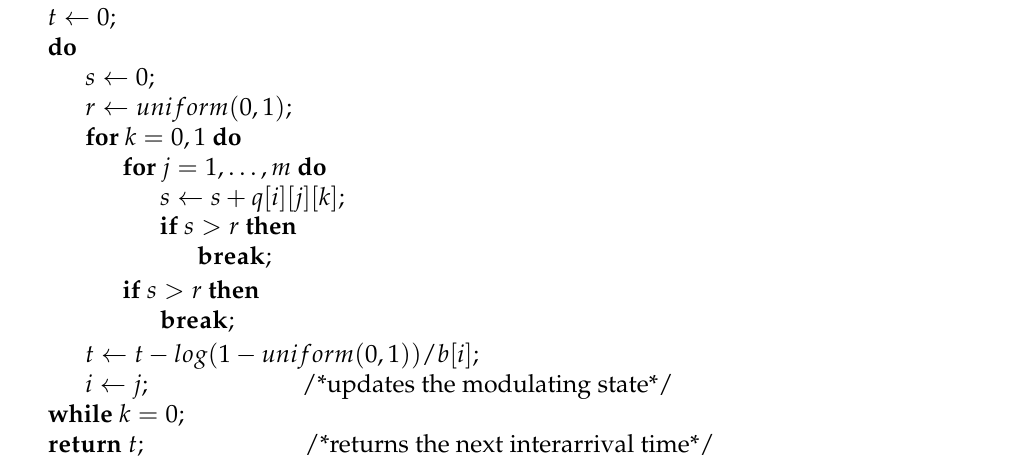
Algorithm 1 MMPP interarrival time generation and state